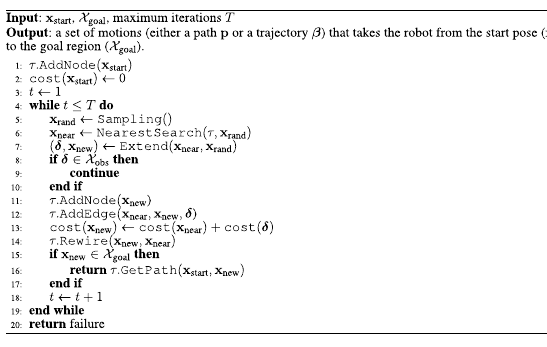
Algorithm 1. RRT*